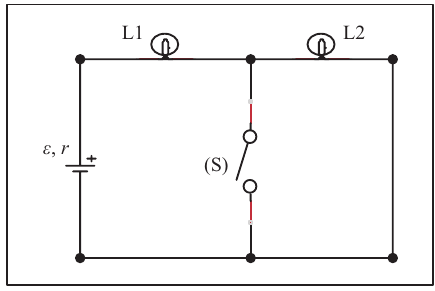
Fig. 6. The brightness of the bulb